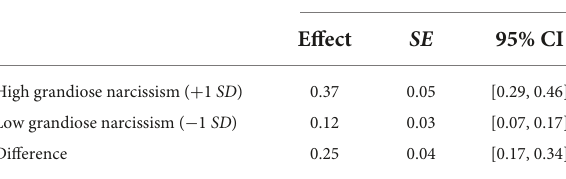
TABLE 6 Mediating effects and 95% confidence intervals at different levels of grandiose